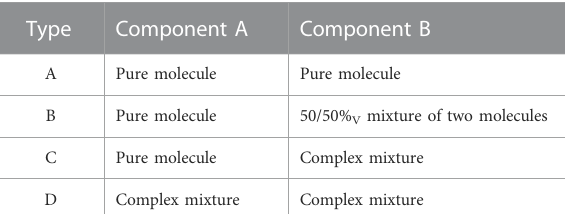
TABLE 3 De fi nition of mixture complexity